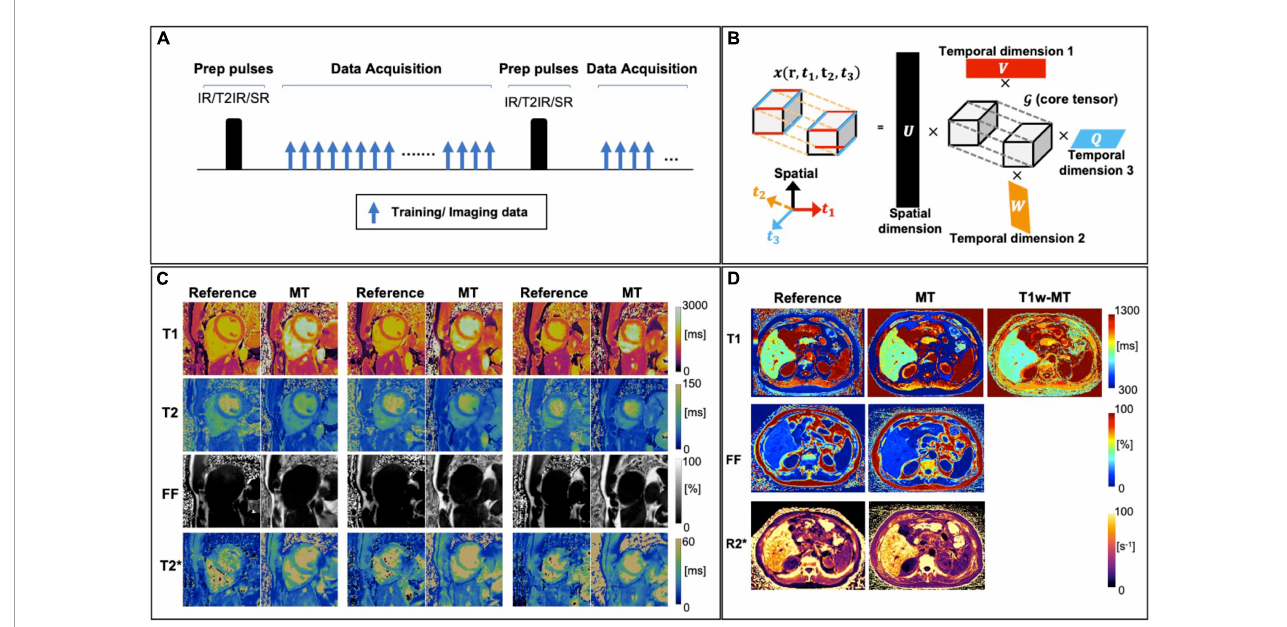
FIGURE9 ( A) A generic sequence diagram for Multitasking technique. The continuous acquisition cycles through different preparation modules (e.g., IR, T 2 -IR, and SR), with FLASH excitations filling the entire recovery period. The training and imaging data are collected in an interleaved way, for resolving temporal and spatial information, respectively. (B) An illustration of multi-dimensional image. In this example, the image tensor contains one spatial dimension r and three temporal dimensions (can be T1/T2/T2 ∗ relaxation, resp motion, cardiac motion, etc.) and its low–rank tensor structure can be explicitly expressed through tensor factorization between 4 sets of basic functions (U, V, W, Q) and a core tensor G . (C) Representative reference and Multitasking cardiac T 1 , T 2 , FF, and T 2 ∗ maps from a healthy volunteer. (D) Representative reference and Multitasking liver T1, T1w (water T1), FF, and R2* maps from a patient with non-alcoholic steatohepatitis. Adapted from Cao et al. (59) and Wang et al.